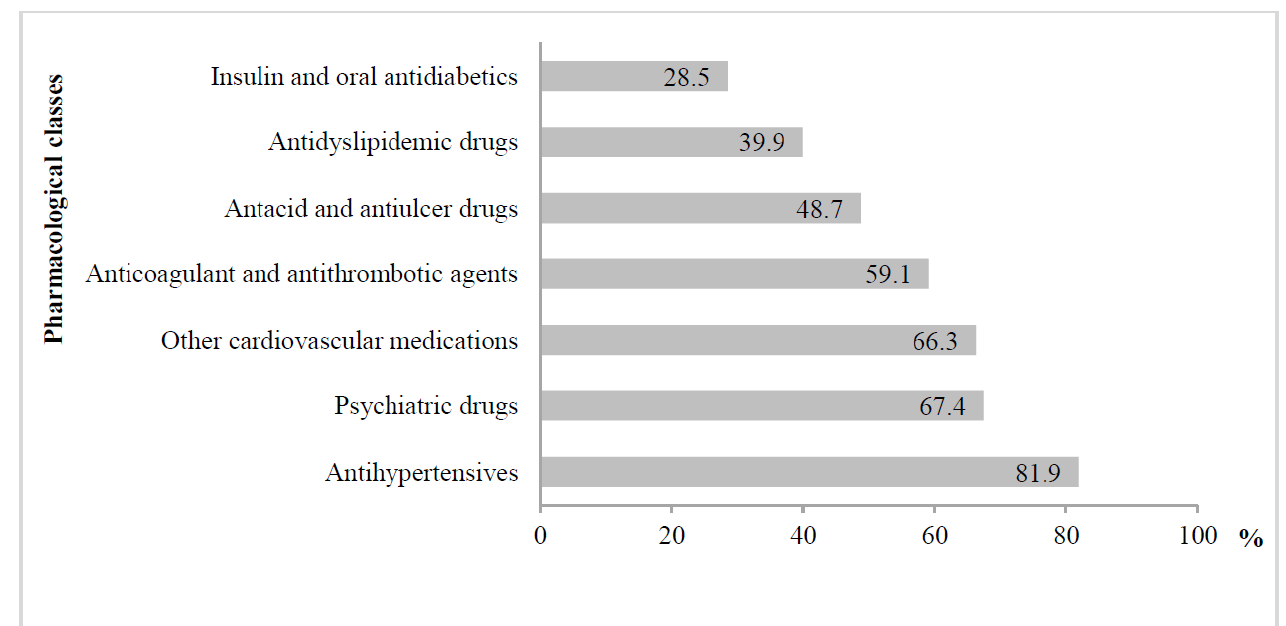
Figure 2. Drug classes most frequently used by the participants of the study (%). According to the Beers Criteria, the pharmacological groups of most found PIMs were short-acting benzodiazepines (alprazolam) (46.6%) and proton-pump inhibitors (omeprazole) (43.5%) (Figure 3). Moreover, long-acting benzodiazepines (diazepam) and antipsychotics such as quetiapine, loxapine, and haloperidol (in descending order) were found.